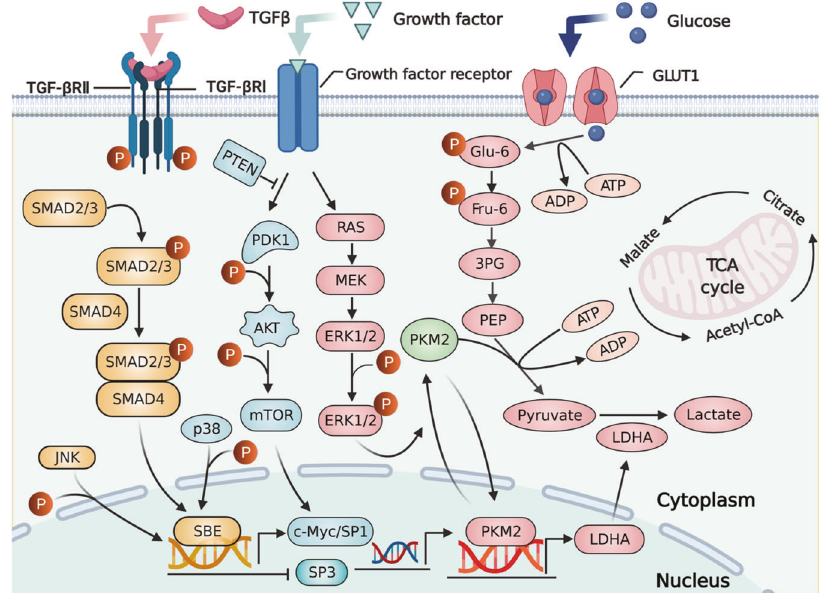
Fig. 6 Schematic overview of TGF- β RII mediating glycolysis via PKM2 nuclear translocation in oral CAFs. TGF- β RII overexpression suppressed glucose metabolism in CAFs by attenuating PKM2 nuclear translocation, and this was triggered by multiple regulators and the related signaling pathways. TGF- β RII overexpression attenuated p-Smad2/3, augmented p-ERK1/2 expression, subsequently might promote PKM2 translocation into the nucleus in oral CAFs. Overexpressing TGF- β RII also downregulated the expression of PKM2 and GLUT1 to reduce the glucose uptake into the